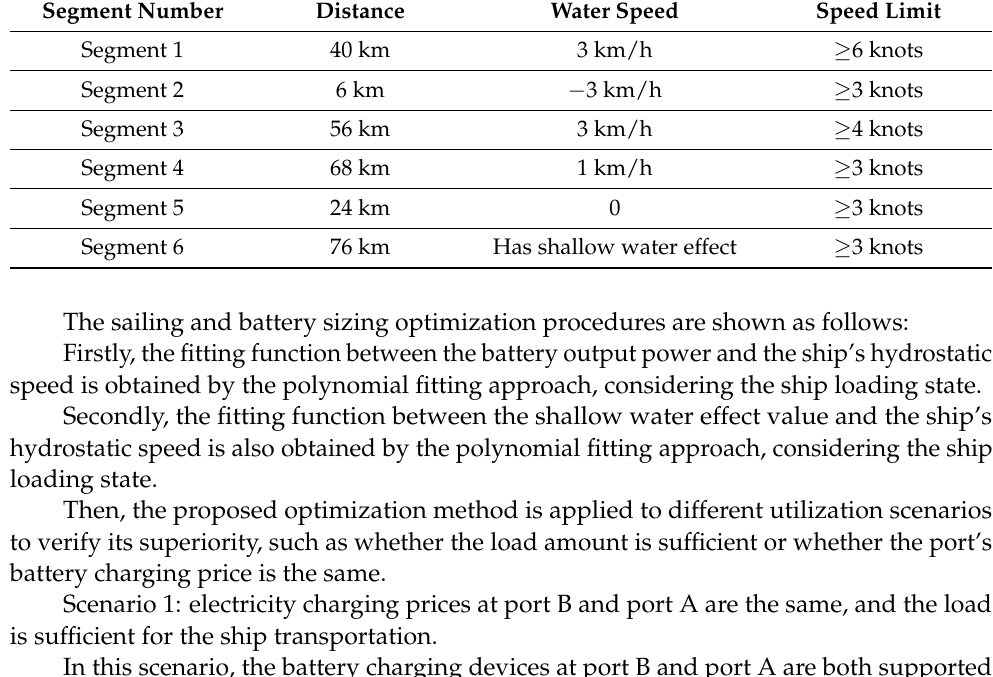
Figure 5. The inland water transport route of case 1.